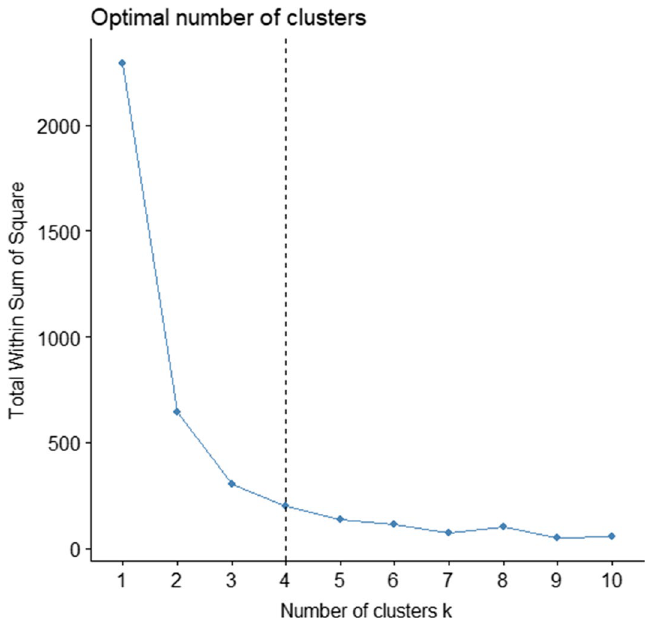
Fig. 2 The optimal clusters of “K” with the elbow